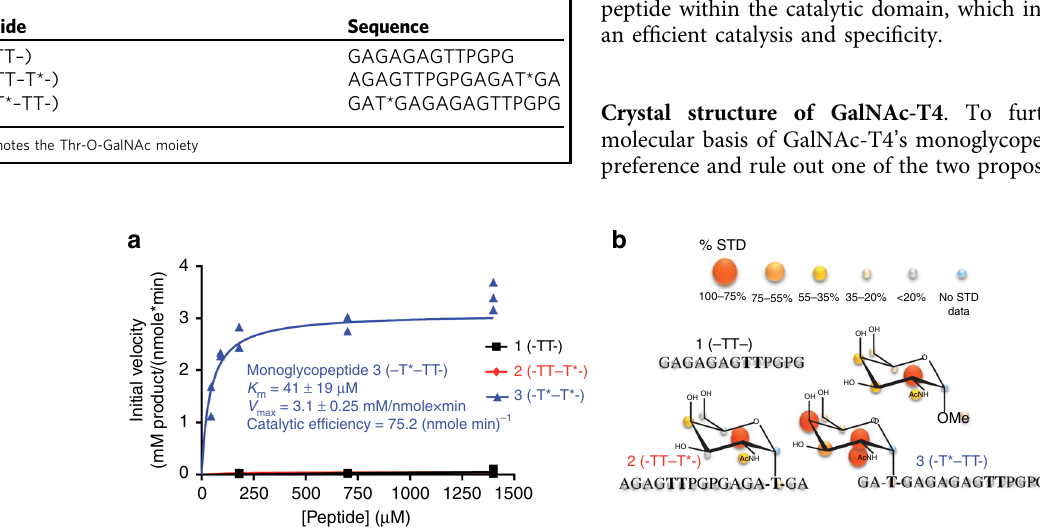
Fig. 2 Biophysical characterization of GalNAc-T4 against peptides 1 – 3. a Peptide glycosylation kinetics of GalNAc-T4 against (glyco)peptides 1 – 3 (black, red, and blue symbols, respectively). Michaelis – Menten kinetic values, K m , V max , and catalytic ef fi ciency ( V max / K m ) for monoglycopeptide 3 were obtained from the nonlinear least square fi t to the initial rate data, obtained as described in the “ Methods ” section and given in Supplementary Table 2. Peptide substrates 1 and 2 are largely unglycosylated by GalNAc-T4. b STD-NMR-derived epitope mapping. The different colored spheres indicate the normalized STD signal (in percent) observed for each proton. See “ Methods ” section and Supplementary Fig. 1 for further